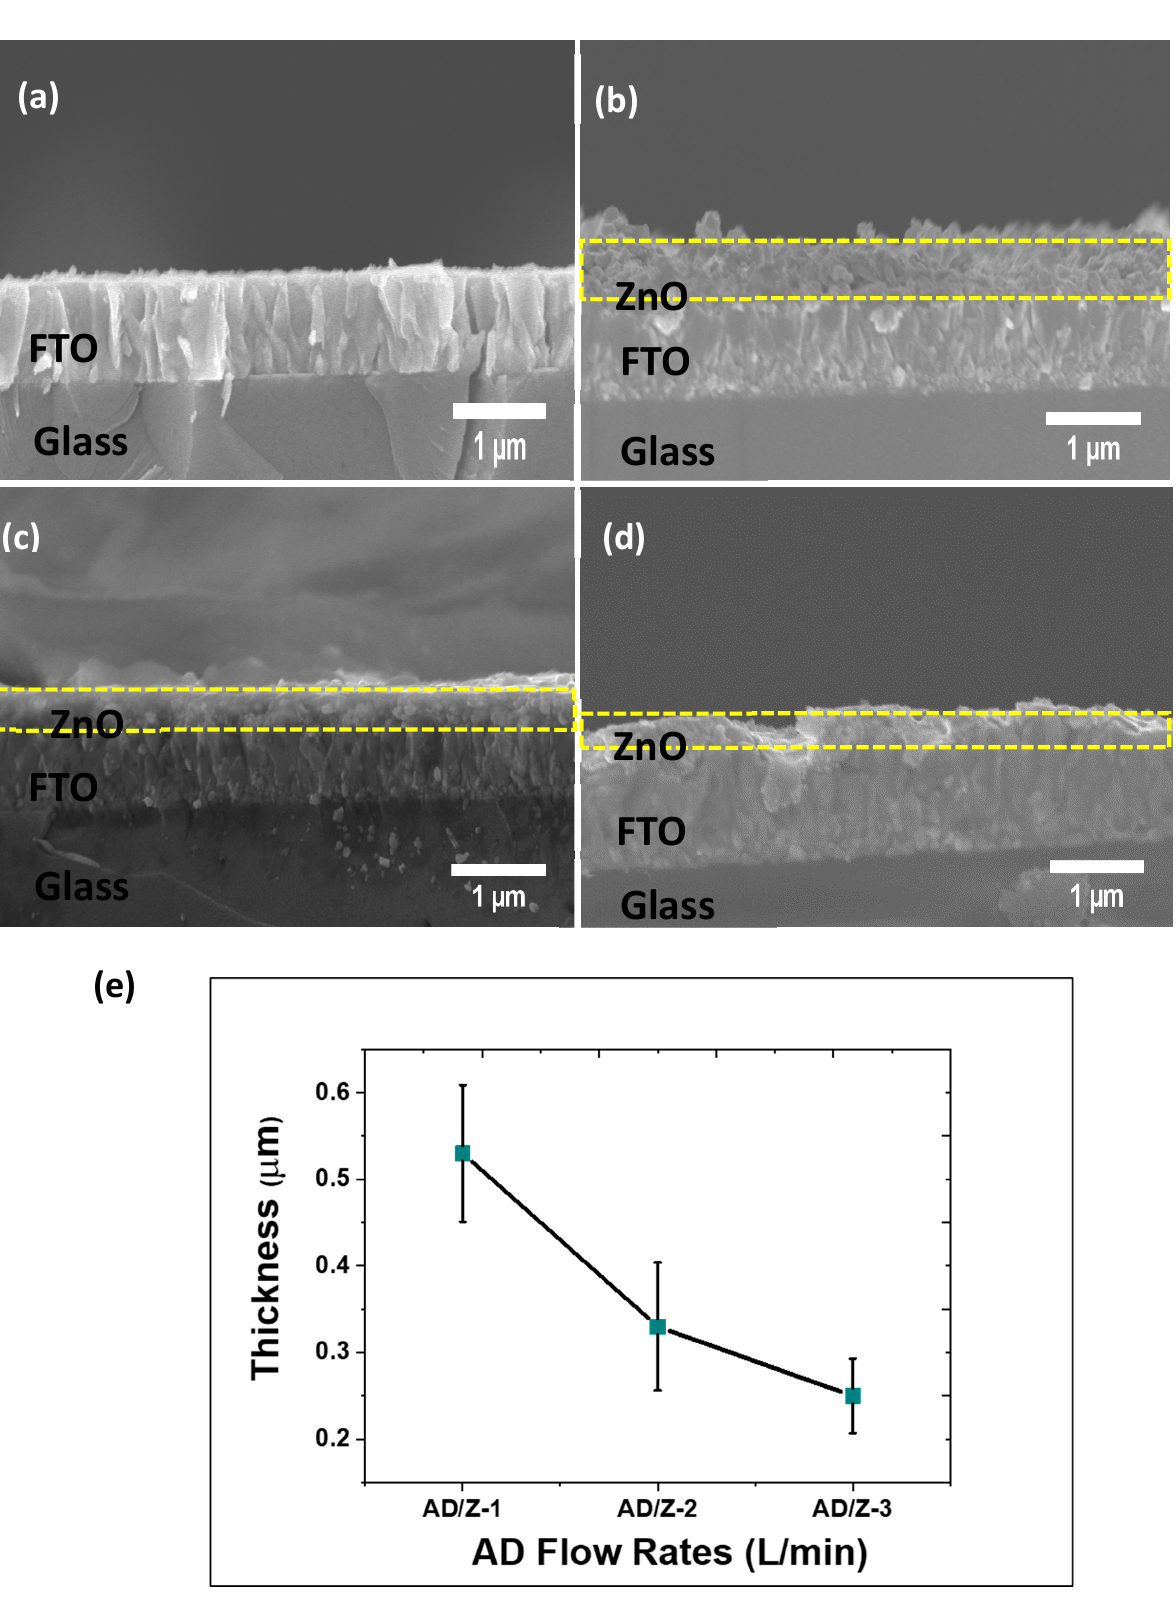
Figure 4. FESEM cross-sectional view of ( a ) bare FTO, ( b ) AD/Z-1, ( c ) AD/Z-2, ( d ) AD/Z-3, and ( e ) the thickness variations in the ZnO films deposited by various AD rates.